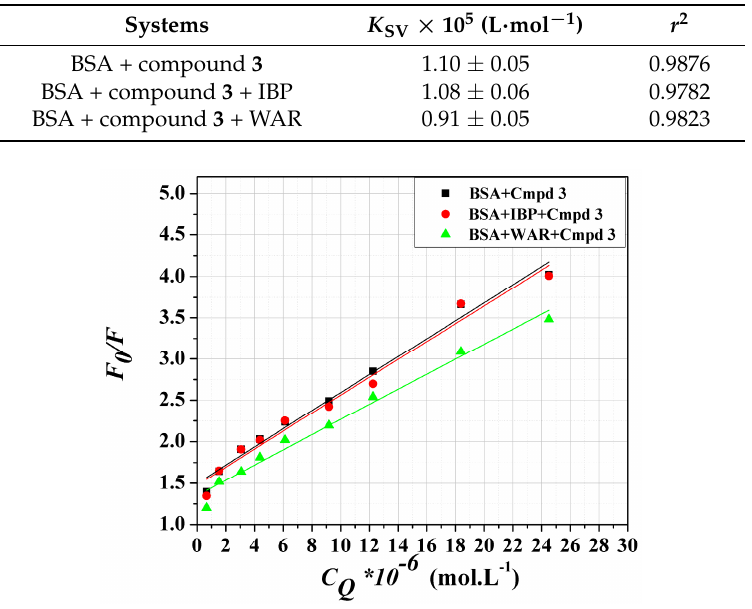
Figure 11. Stern–Volmer correlation derived from the BSA interaction with compound 3 at 298 K in the presence of WAR and IBP as the site